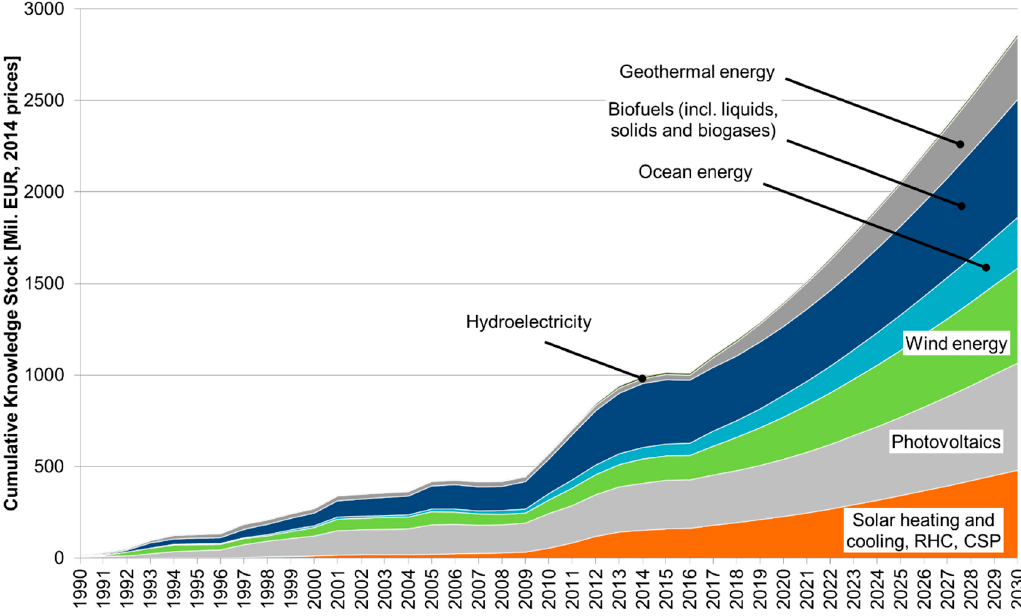
Figure 8. Cumulative RES knowledge stock induced by public R&D expenditures of the EC (Mil. EUR, advanced scenario) (2014 prices and exc. rates; knowledge depreciation, 10%; time lag, three years).